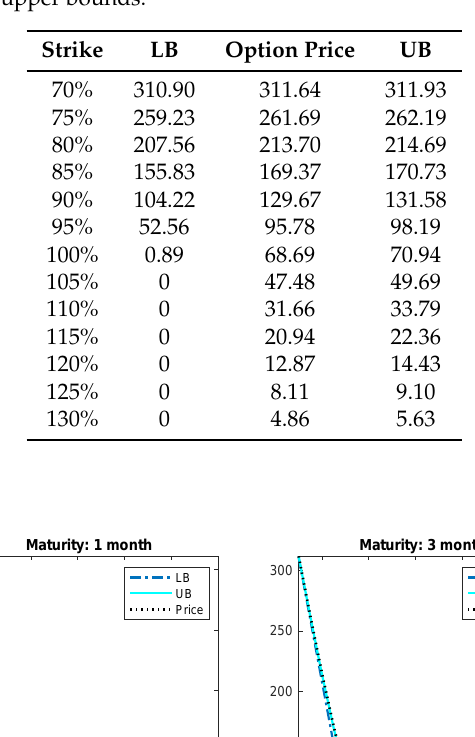
Table 2. European freight call option prices with a maturity of 3 months, for several strikes and their corresponding lower and upper bounds.